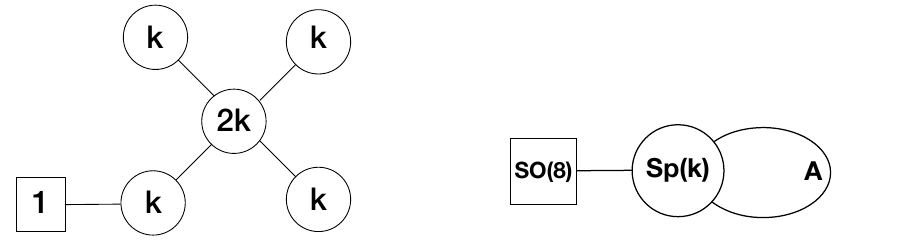
Figure 3 . ADHM quiver for k SO(8) instantons (right) and its dual quiver with b D 4 symmetry